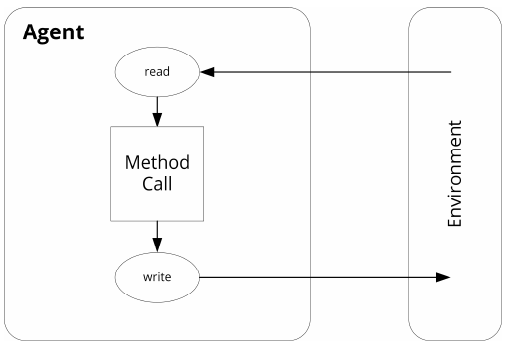
Figure 6. An agent as part of a simulation system, which is described in a highly abstracted way by a single monolithic model implemented by a single method. This way of dealing with the simulation participants is often sufficient for simple high-level simulations, as they are often used at the beginning of the development. Illustration based on [25].